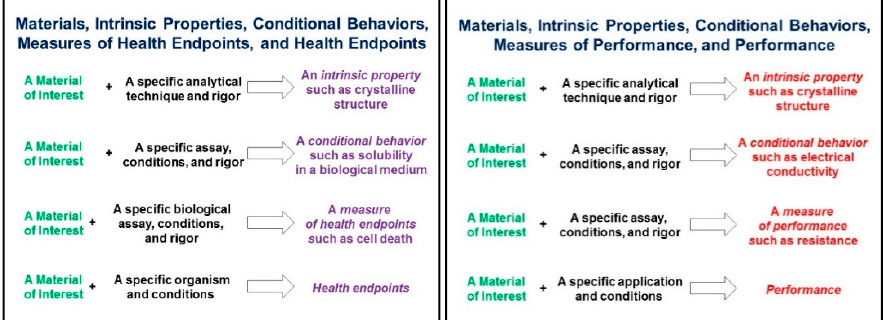
Figure 1. Example study purposes and designs to create data related to health and health endpoints ( left ) and physicochemical or other performance ( right ) for evaluations of the intrinsic properties and conditional behaviours of nanomaterials [30]. Reused with permission from Elsevier, License Number: 4926970512437.